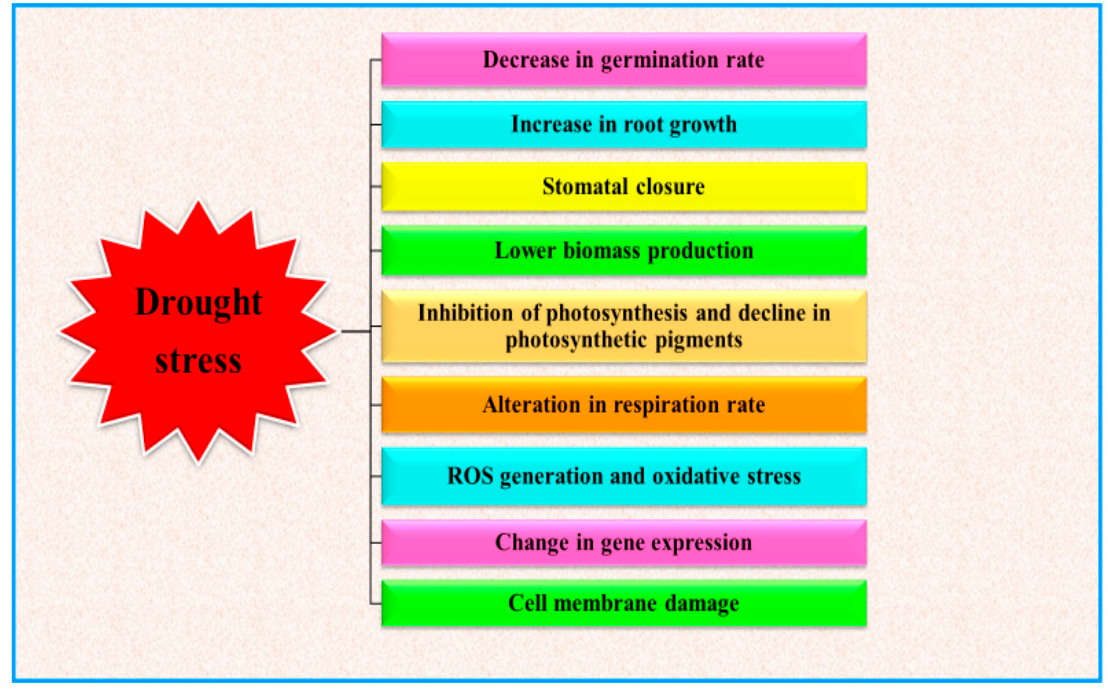
Figure 1. Effect of drought stress on plant growth and development (modified from Ghatak et al.